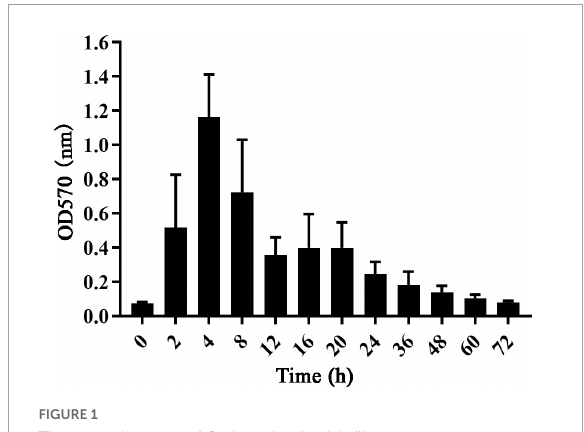
FIGURE1 The growth curve of S. dysgalactiae